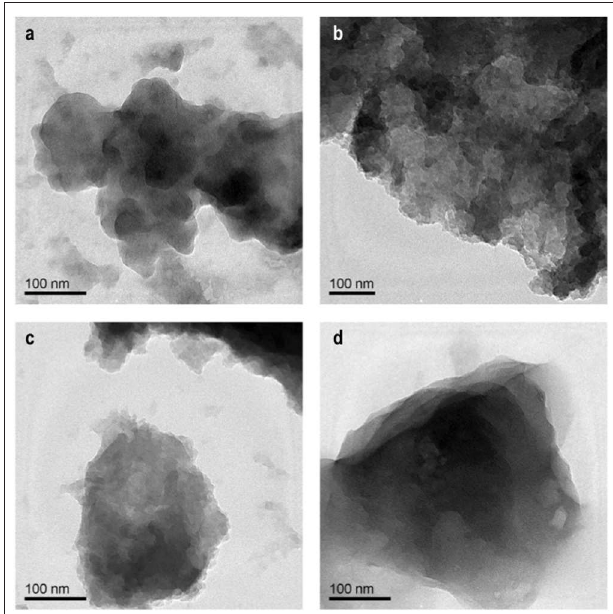
FIGURE 2 | Representative TEM images: (a) NDRGO-Li-S. (b) NDRGO-Li-2S. (c) NDRGO-Li-4S. (d) NDRGO-Mo-Li-2S.